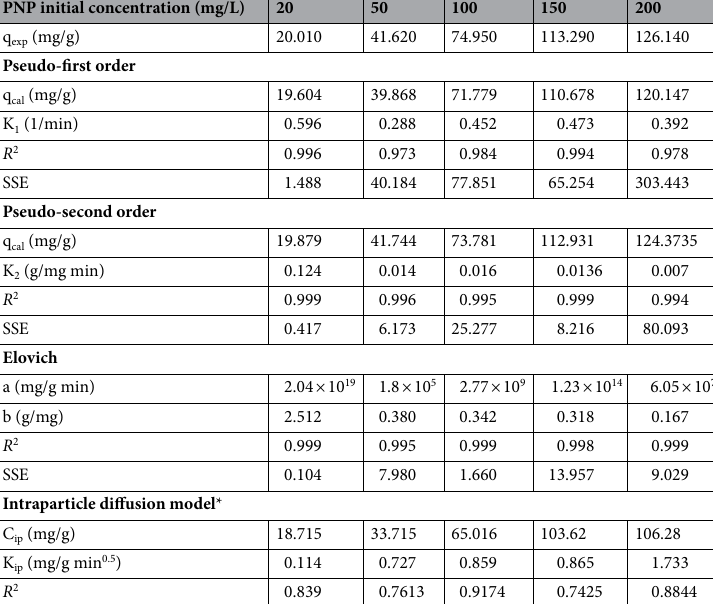
PNP initial concentration